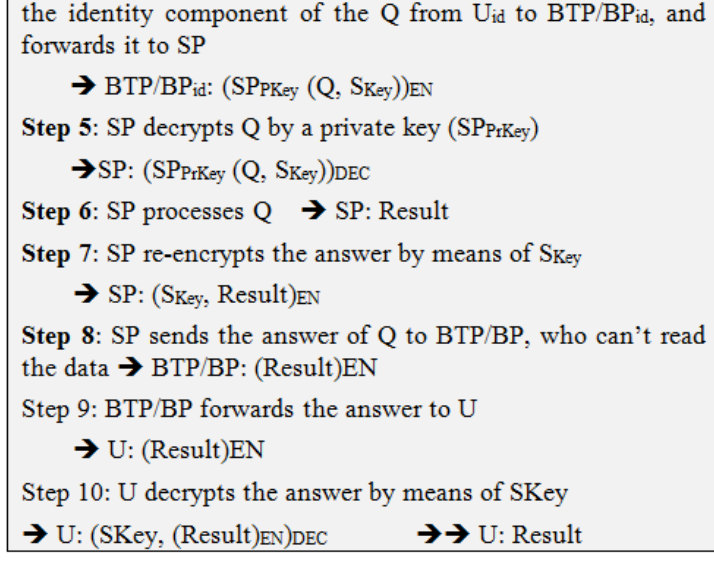
Figure 6. Steps of the query transaction in B L A .